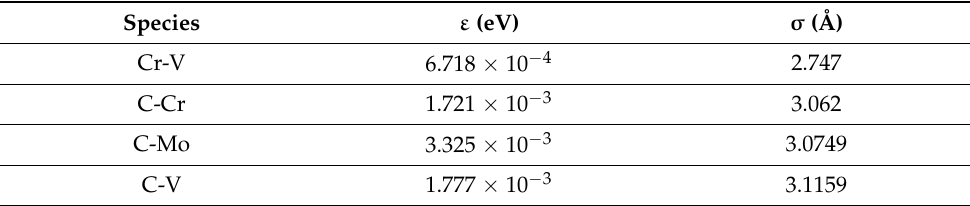
Table 2. Lennard Jones energies ( ε ) and distances ( σ ) for Cr, V, Mo, and C.